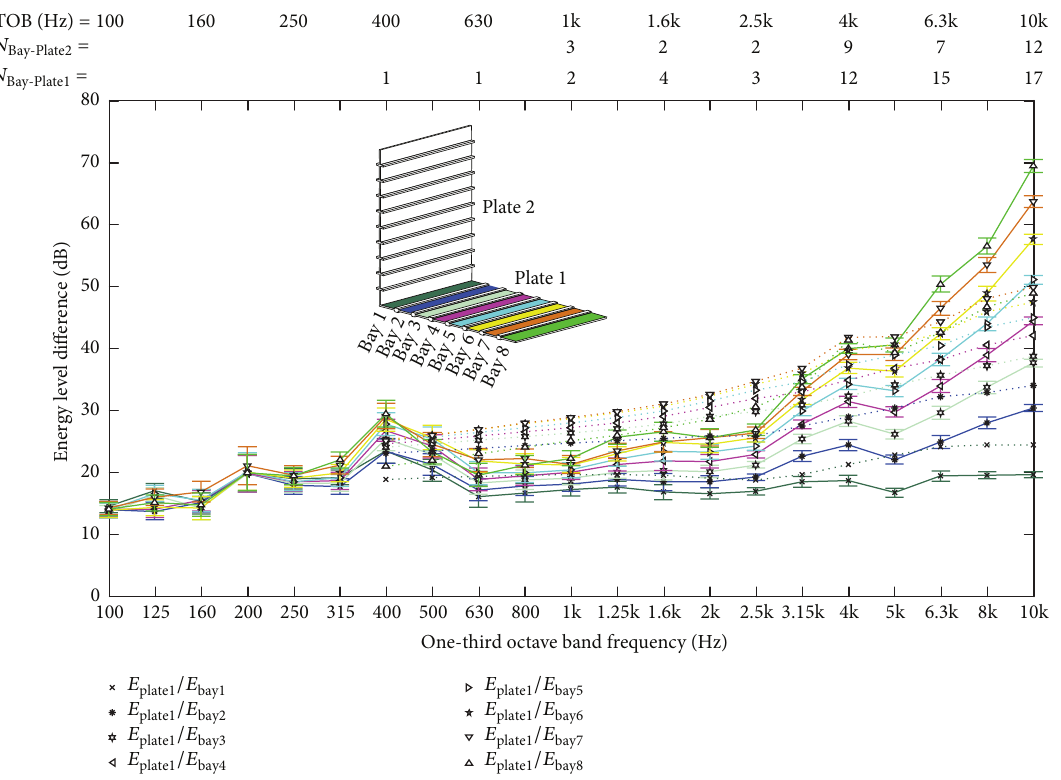
Figure 8: L-junction B. Excitation: Plate 2. Energy level differences between the periodic ribbed plate (Plate 2) and each of the bays that form the other periodic ribbed plate (Plate 1). Comparison between FEM and ASEA (FEM data are shown using markers with continuous lines; ASEA data are shown using markers with dotted lines). Upper 𝑥 -axis indicates the mode counts for each bay of the ribbed plates ( 𝑁 and 𝑁 Bay-Plate2